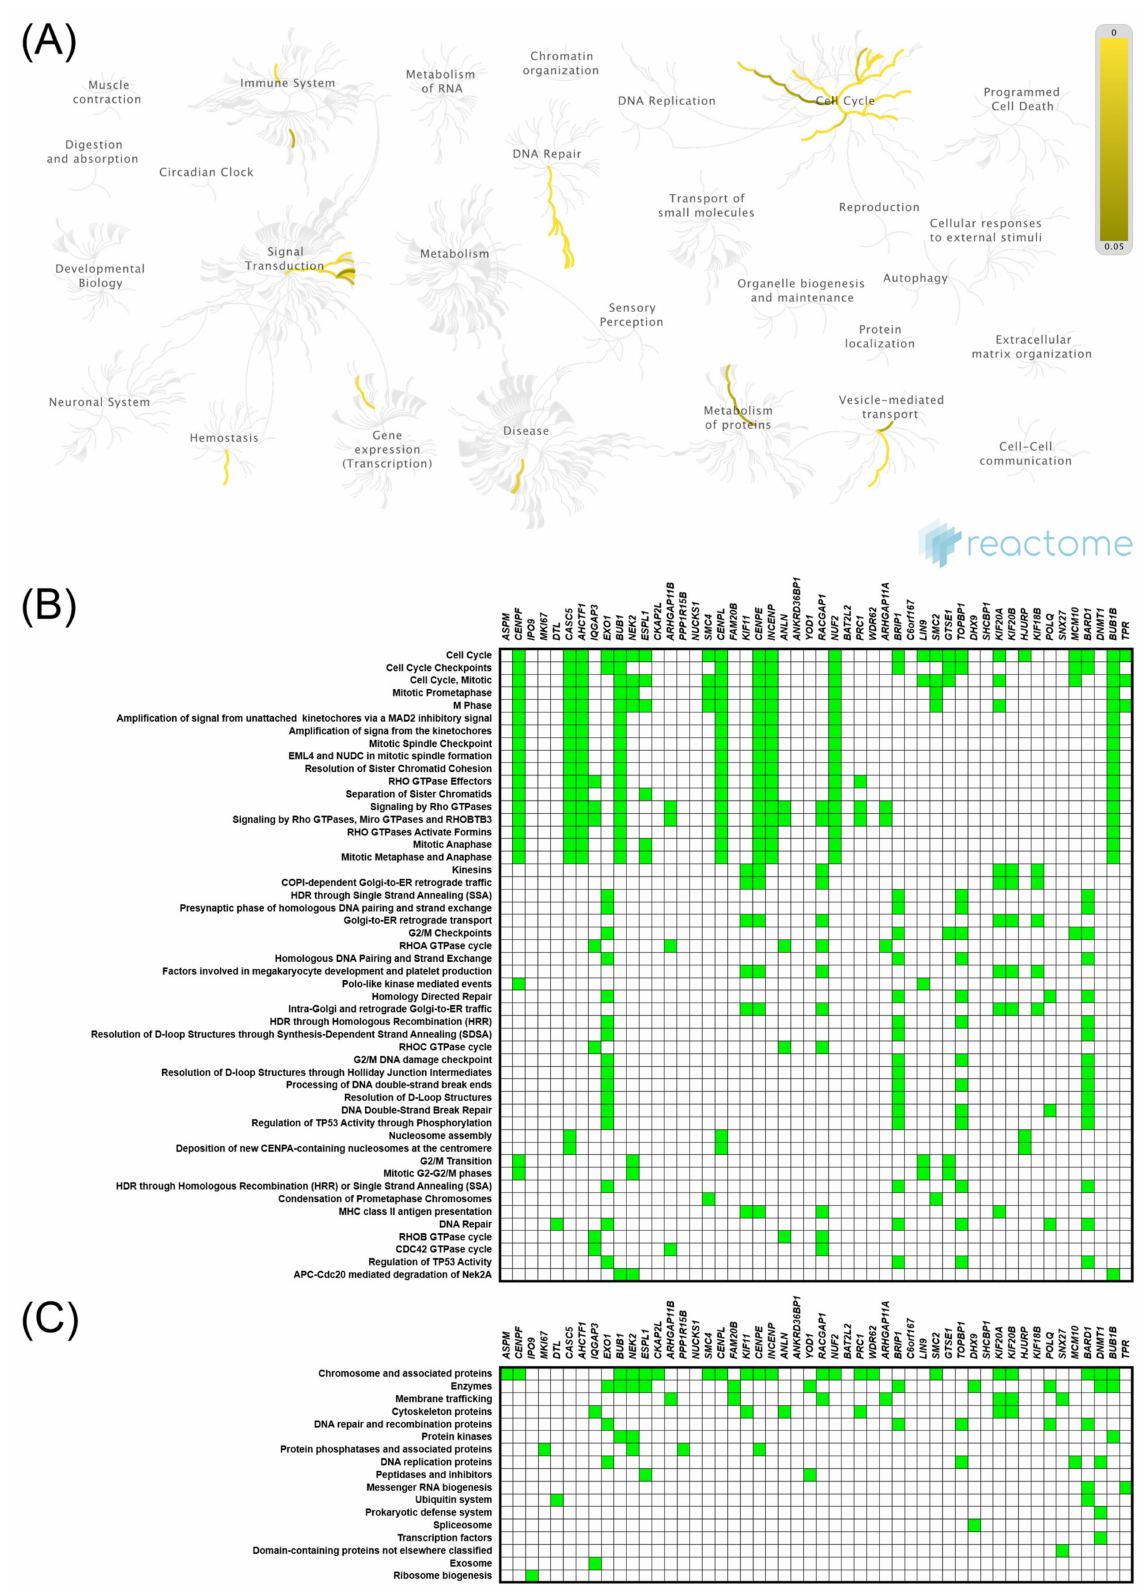
Figure 5. Functional enrichment analysis based on the TCGA dataset and UALCAN web tool. The top 50 genes and reactome pathways positively correlated with KIF14 expression ( A , B ); BRITE functional hierarchies for the top 50 genes that were co-upregulated with KIF14 ( C